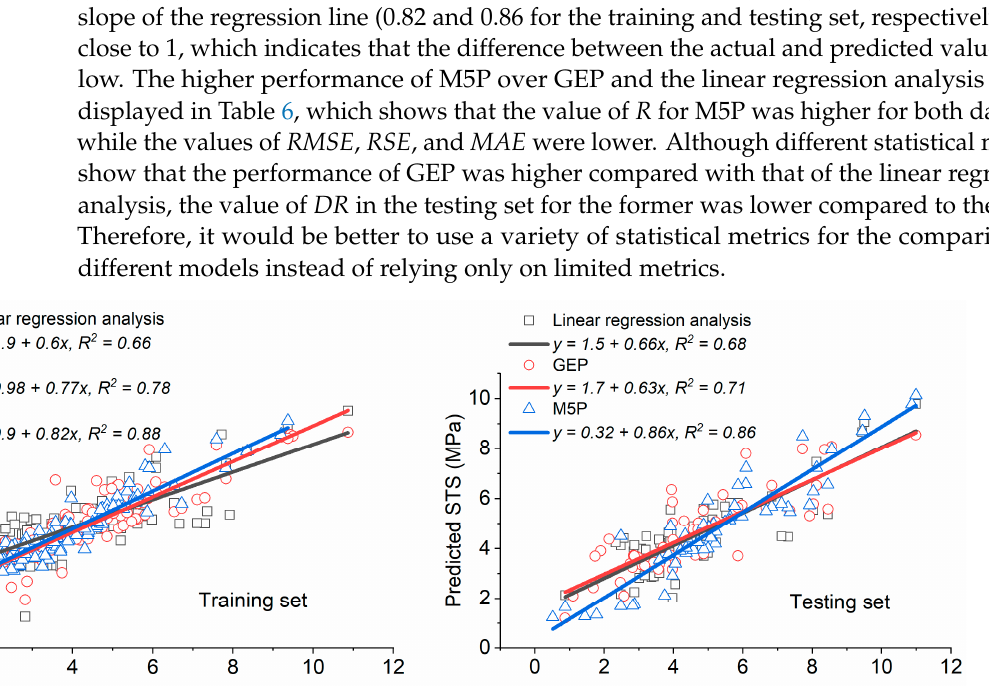
Figure 9. Comparison of the linear regression analysis, GEP, and M5P for the prediction of STS of concrete made with SF: ( a ) training set; ( b ) testing set. Table 6. Comparison of the different models developed for the STS database.